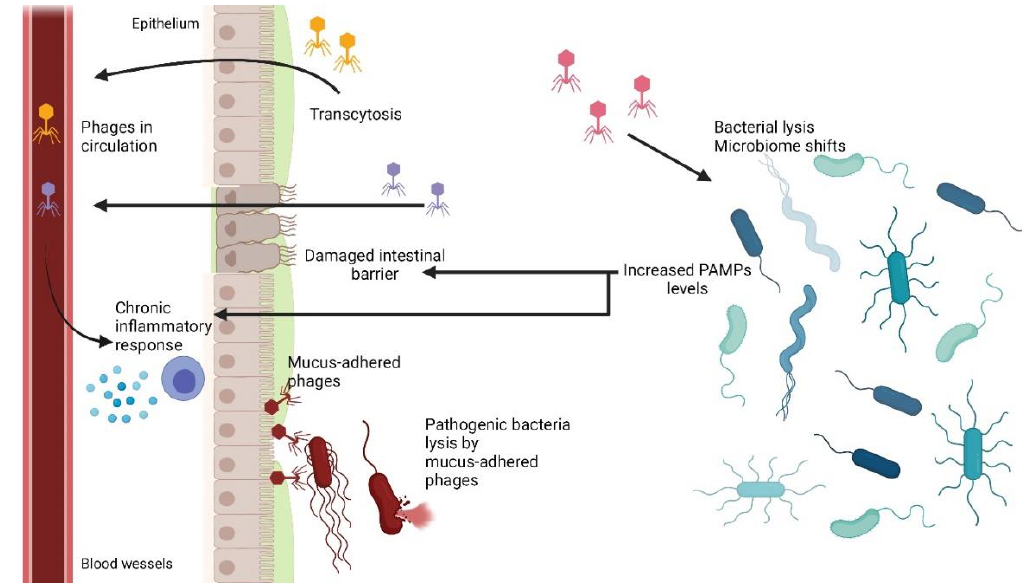
Figure 6. Concept of phage interactions with environment in intestine as proposed by Tetz and Tetz [133] and Barr et al. [138] (modified).